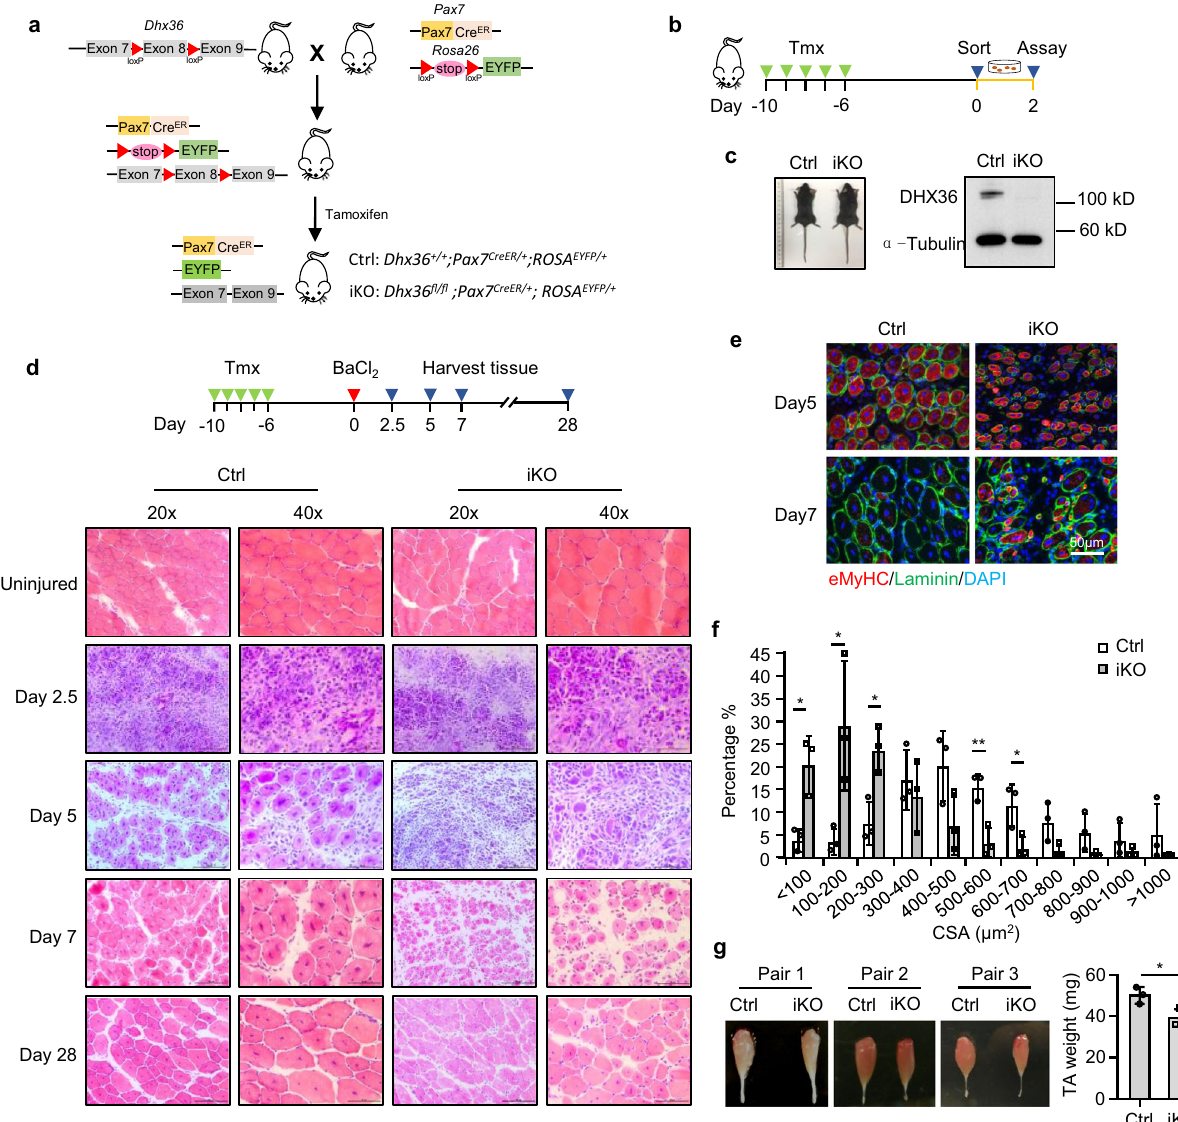
Fig. 2 Dhx36 inactivation in adult SCs impairs muscle regeneration. a Schematic illustration of the strategy to inactivate Dhx36 in inducible knockout (iKO) mice. Dhx36 fl / fl mice were mated with Pax7 CreER ; ROSA EYFP mice; the exon 8 of Dhx36 was deleted in the iKO mice after Tamoxifen (Tmx) injection which also resulted in the removal of the stop signal for YFP at the Rosa26 site to allow the expression of YFP in iKO SCs. b Schematic illustration of fi ve doses of Tmx injection to delete Dhx36 in the iKO mouse. Freshly isolated SCs were collected at day 6 post-injection and cultured for 2 days. c Left: no obvious morphological difference was observed in representative Ctrl vs iKO mice. Right: loss of DHX36 protein was con fi rmed by western blot with α - Tubulin as the loading control. d Upper panel: schematic illustration of the injury-induced muscle regeneration scheme. BaCl 2 was injected into TA muscles of the above Ctrl or iKO mice 6 days post-Tmx injection to induce acute injury. The injected TA muscles were harvested at the designated times for the assessment of the regeneration process. Lower panel: H&E staining of the TA muscles collected at 2.5, 5, 7, and 28 days post injury. Scale bar = 100 μ m (×20) or 50 μ m (×40). e IF staining of eMyHC (red) and laminin (green) was performed on the TA muscles collected at 5 and 7 days post BaCl 2 injury. Nuclei were visualized by DAPI staining (blue). Scale bar = 50 μ m. f CSAs of newly formed fi bers were quanti fi ed from the above-stained sections and the distribution is shown, Ctrl in white bars and iKO in gray bars; n = 3 mice per group. <100 μ m, P = 0.013; 100 – 200 μ m, P = 0.038; 200 – 300 μ m, P = 0.016; 500 – 600 μ m, P = 0.009; 600 – 700 μ m, P = 0.036. g Left: Representative images of TA muscles collected at 28 days post injury are shown. Right: The muscle weight from three pairs of mice, P = 0.031. Data are represented as mean ± s.d., Student ’ s t test (two-tailed unpaired) was used to calculate the statistical signi fi cance ( f , g ): * P < 0.05, ** P < 0.01. Source data are provided as a Source Data fi